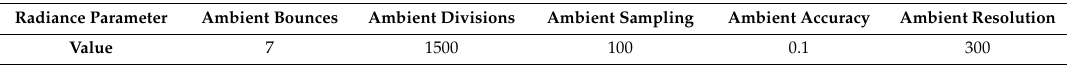
Figure 4. Exterior and interior 3D reference model and furniture arrangement. Table 3. Radiance parameters used in the daylighting